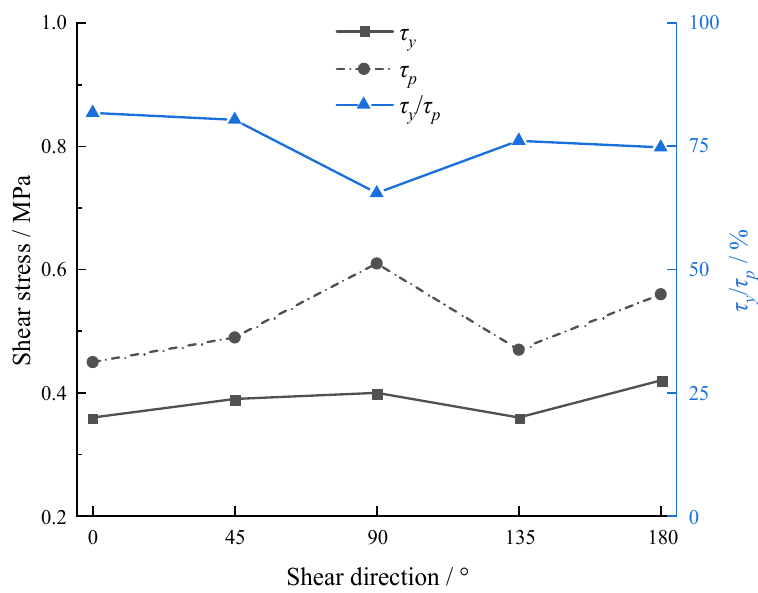
Figure 18. Yield stresses under different shear directions (Note: τ p data are from Bao et al. [81]).